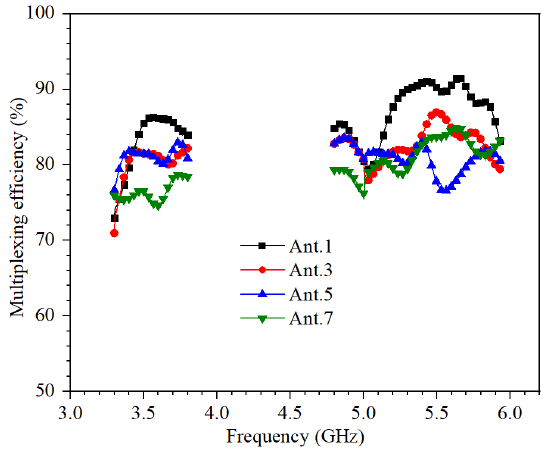
The calculated ME of the proposed MIMO antenna system is shown in Figure 10. The values of ME in the operating frequency bands are greater than 70%.